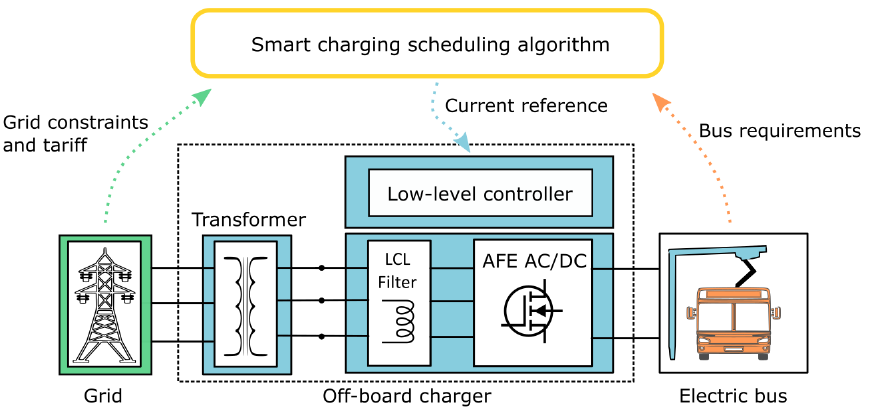
Figure 1. Overview of the charging system and control architecture.